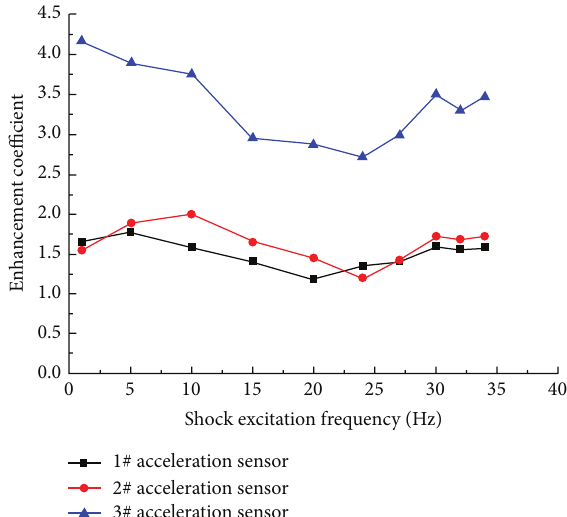
Figure 17: Enhancement coefficient curve of the acceleration response (0.1g).